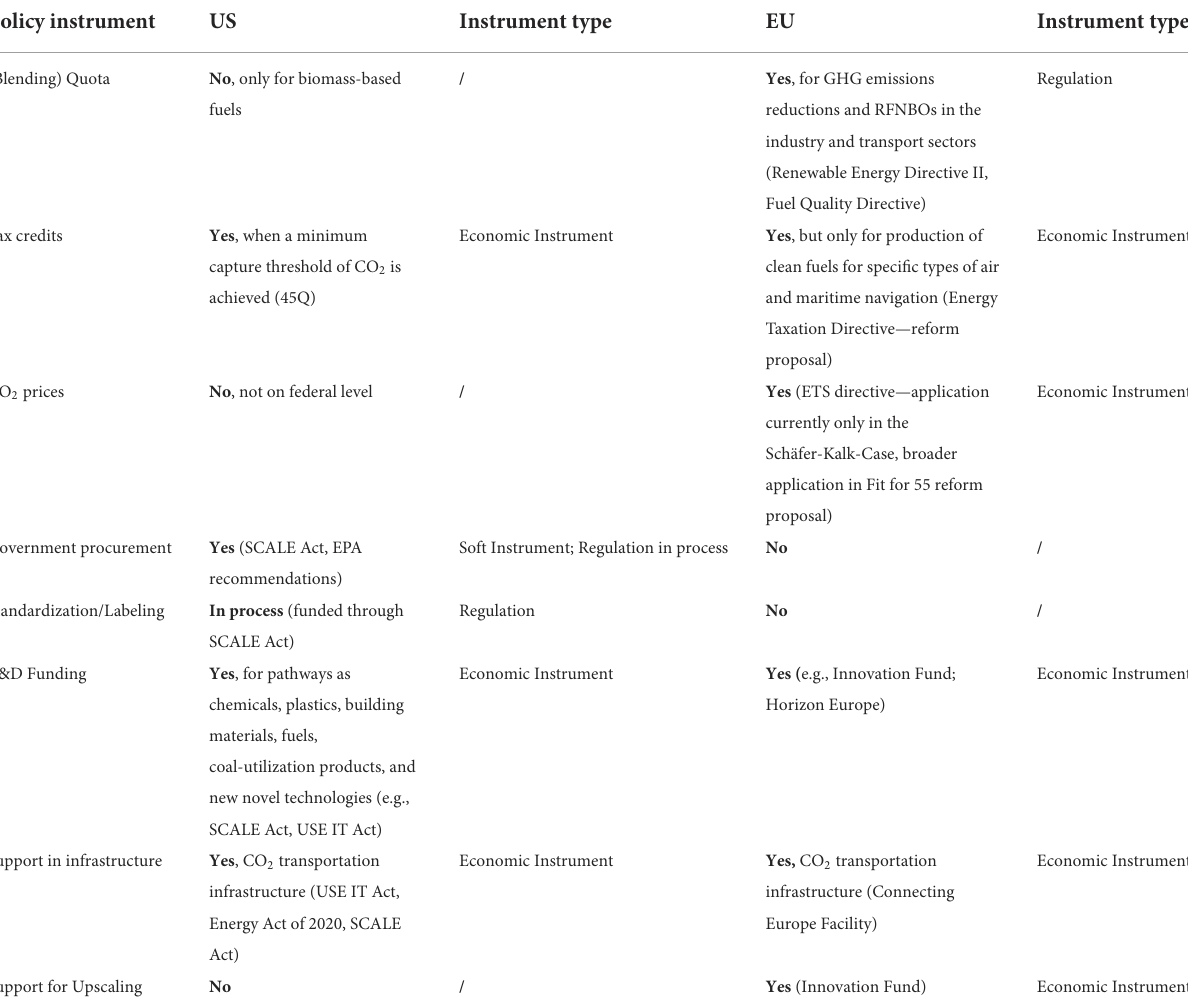
TABLE 1 Comparison of policy instruments addressing CCU in the US and